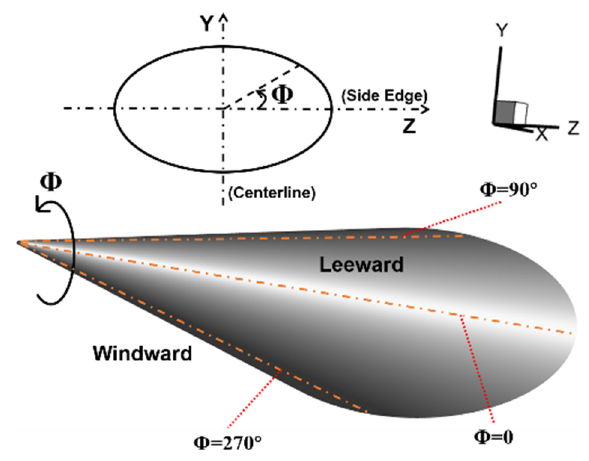
Figure 15. Azimuth diagram of HIFiRE-5.